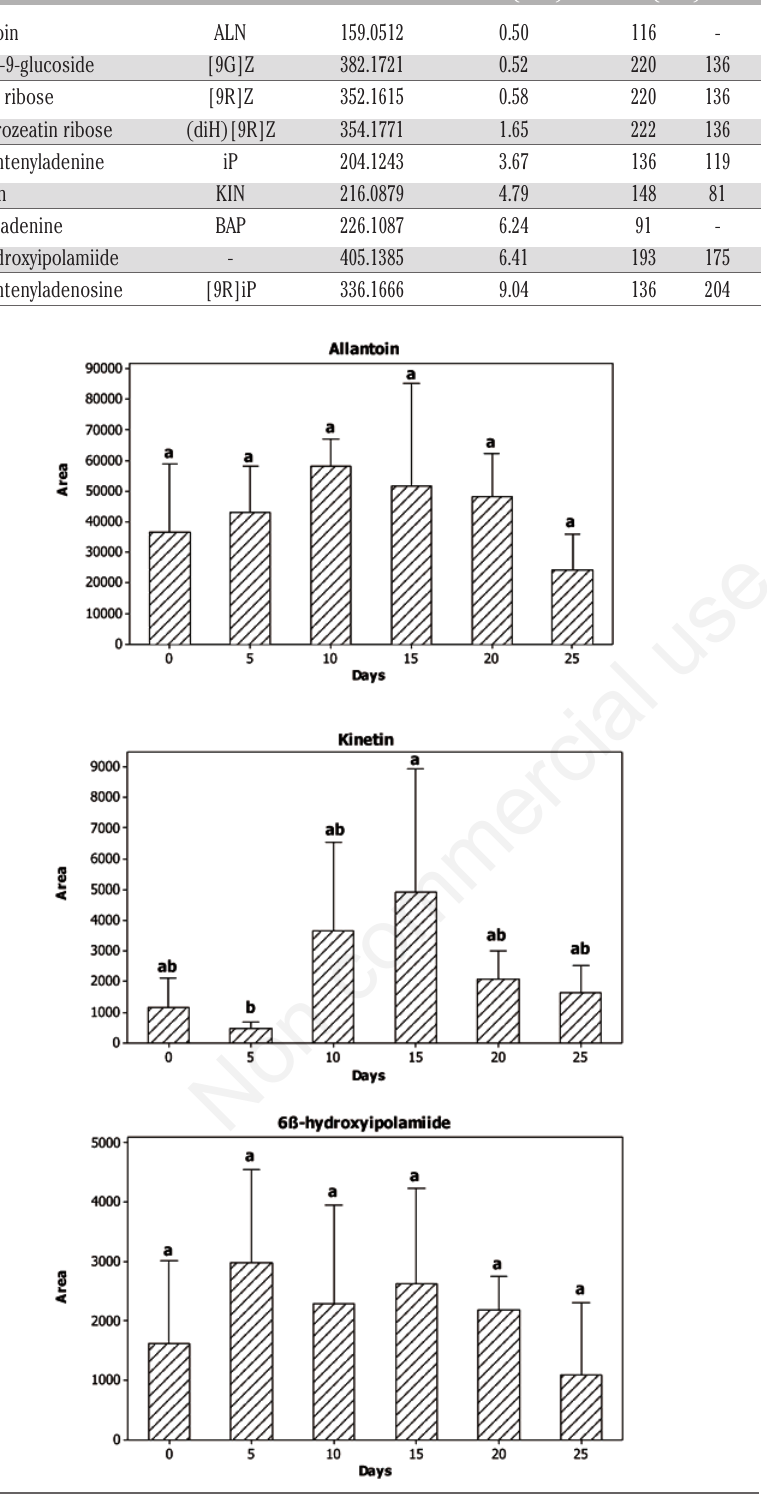
Figure 2. Areas of the peaks corresponding to allantoin, kinetin and 6(cid:0)-hydroxyipolami- ide in the HPLC/MS chromatogram of the stalk samples of Adenocalymma peregrinum at different periods after removal of the aerial parts of plants established in the field. Same letters indicate values that do not differ from each other by the Tukey test with a 5% probability of